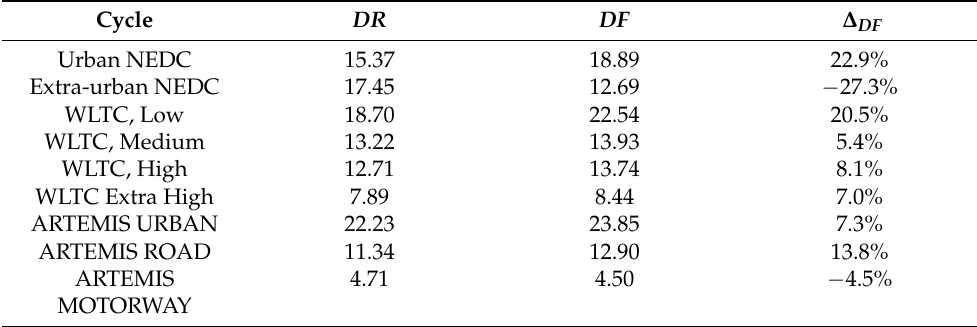
Table 4. Dilution ratio ( DR ) and dilution factor ( DF ) in each phase of NEDC, WLTC and ARTEMIS driving cycles for vehicle with SI engine, Euro 6 NEDC.